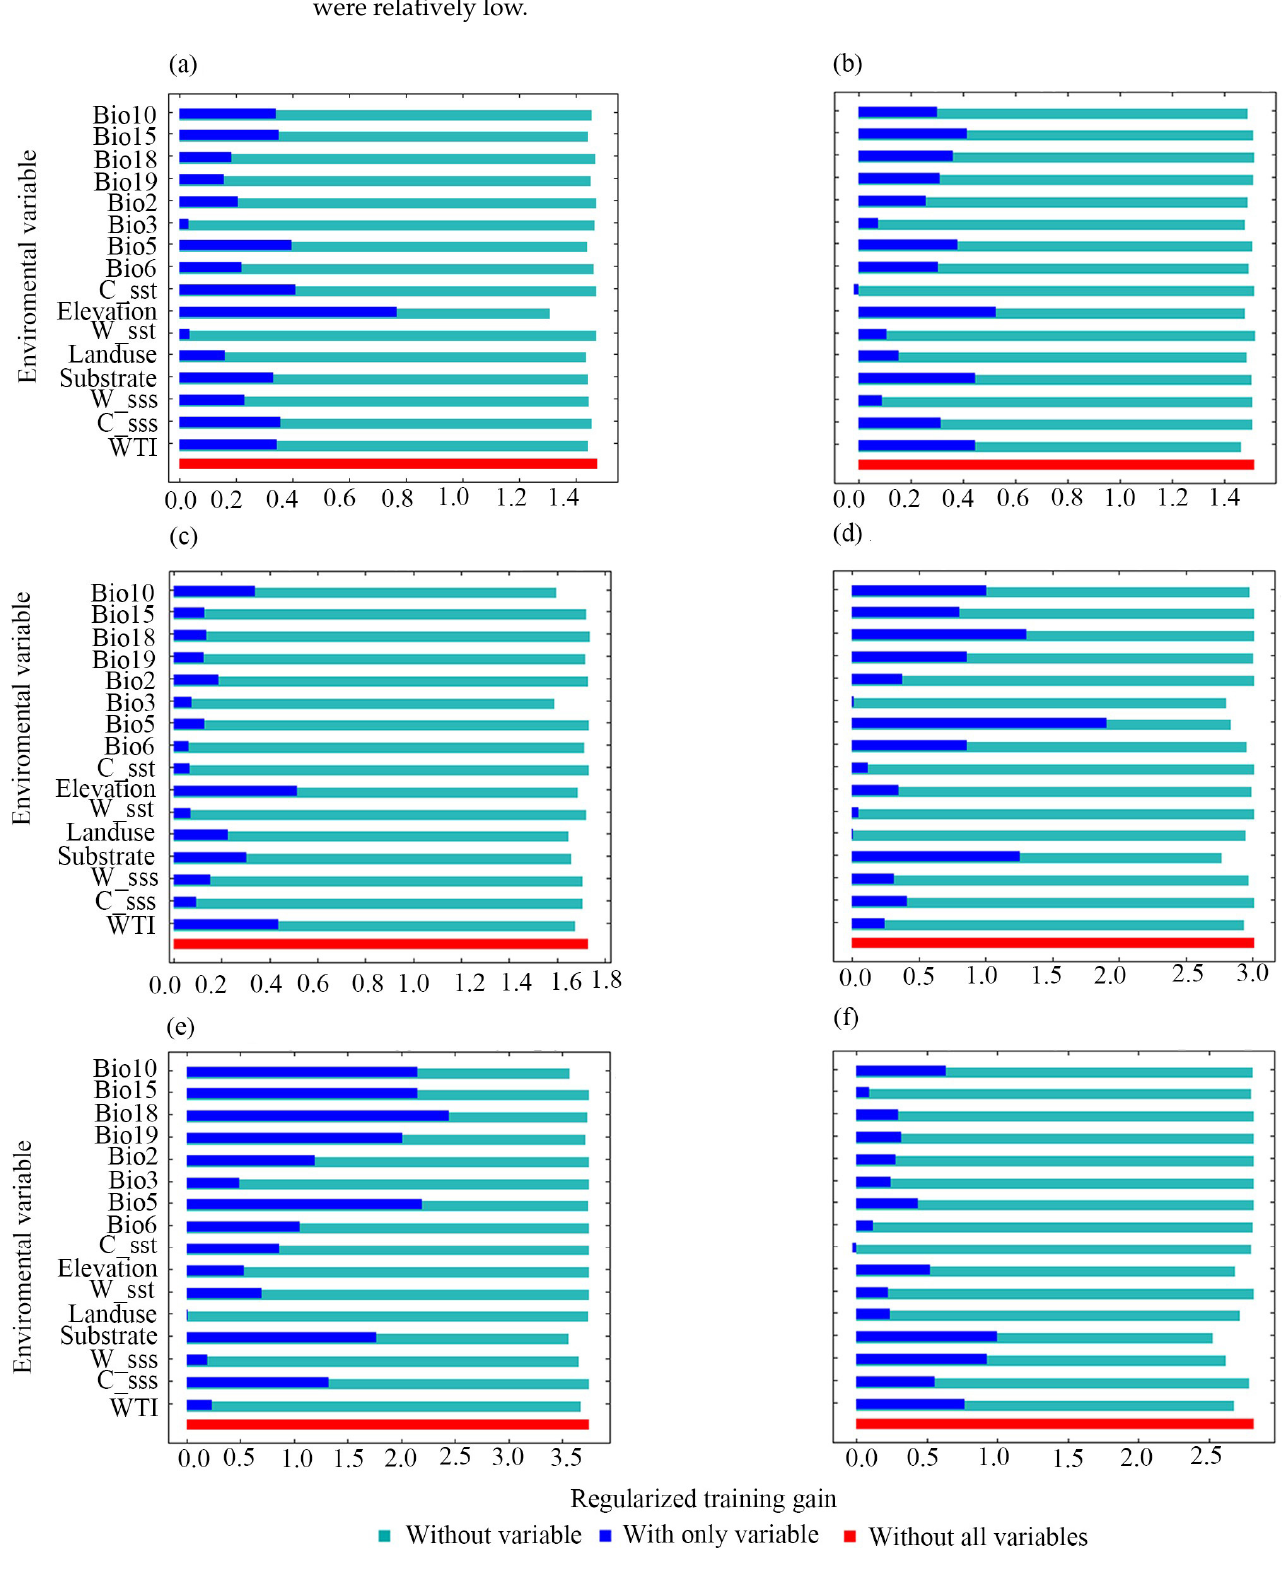
Figure 8. The regularized training gains for the six mangrove species: ( a ) A. marina , ( b ) A. corniculatum , ( c ) K. obovata , ( d ) B. gymnorrhiza , ( e ) R. stylosa , and ( f ) A. ilicifolius (entry definitions are the same as in Figure 5).